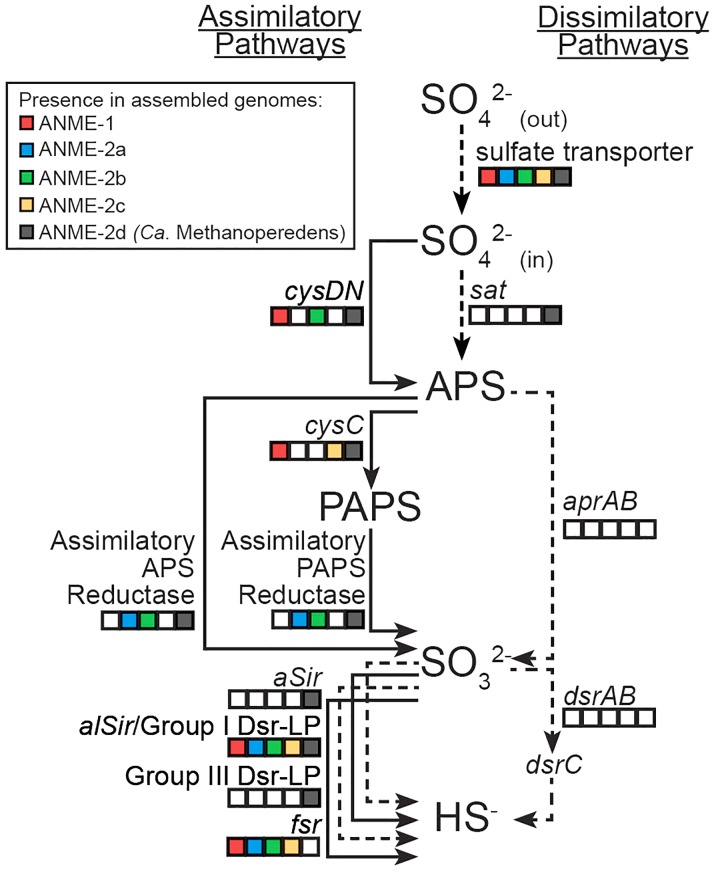
Sulfur assimilatory and dissimilatory pathways in different ANME lineages. Squares are color-filled based on the presence of particular gene(s) in ANME-1/2a/2b/2c and Ca. Methanoperedens (ANME-2d). Lines are solid and dotted based on the presence or absence of particular gene(s) in marine ANME lineages that live syntrophically with SRB partners. Putative sulfate transporters or sat could be used for either assimilatory or dissimilatory sulfate reduction. Known genes in the dissimilatory pathway (aprAB, dsrAB and their membrane complexes) were not identified in any ANME lineage.